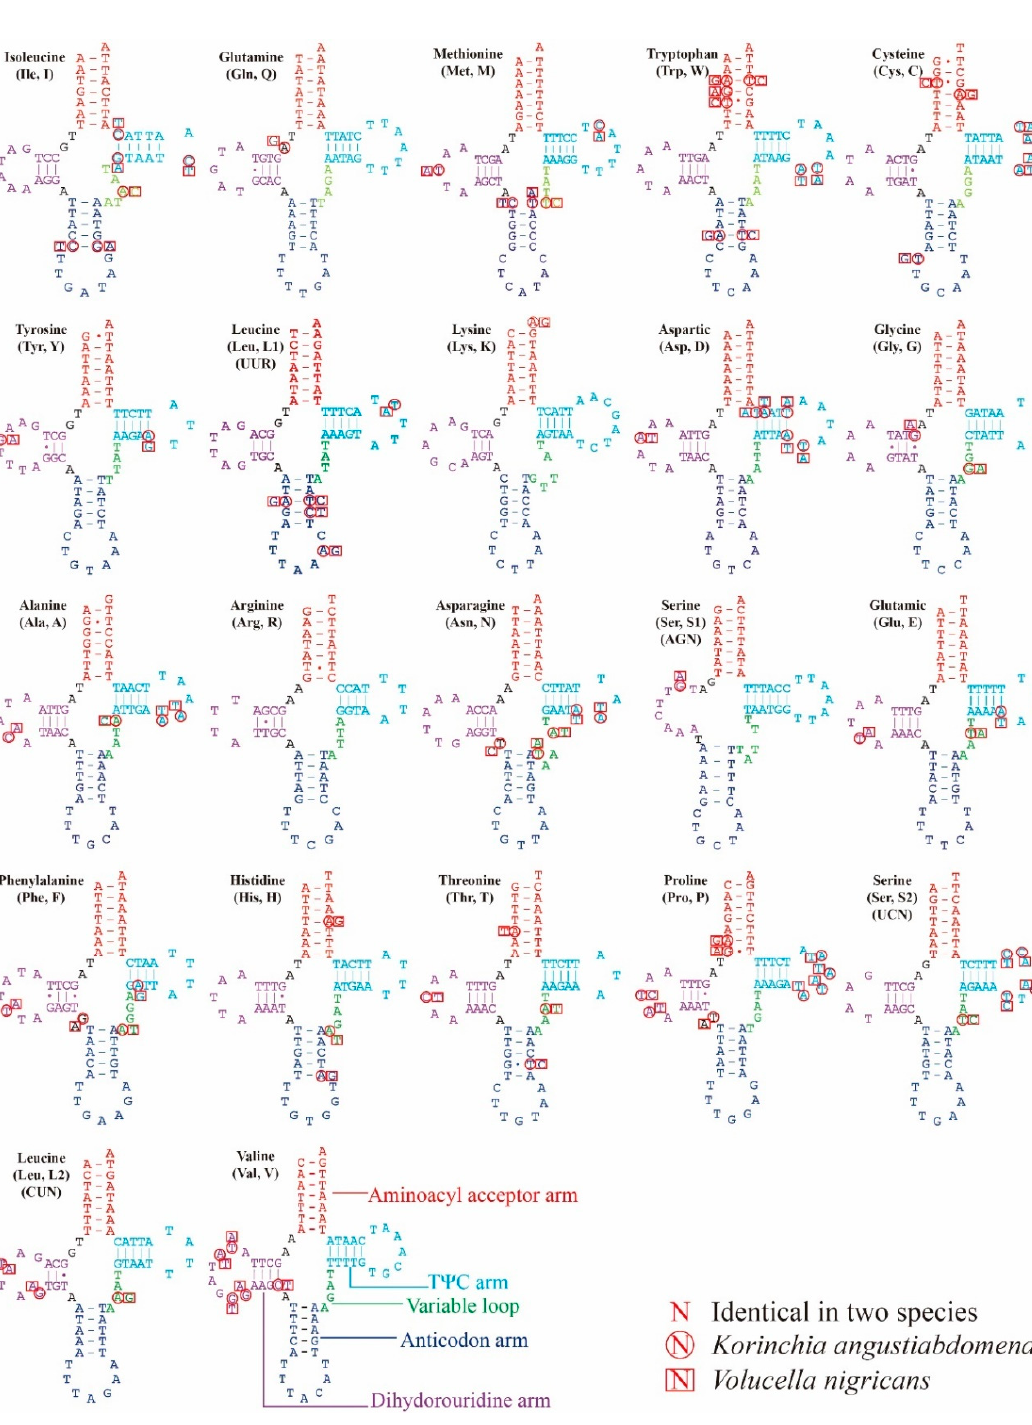
Figure 5. Predicted secondary structures of the 22 tRNAs in Korinchia angustiabdomena and Volucella nigricans . Dashes (–) indicate Watson–Crick base pairing and dots (.) indicate G-U base pairing.